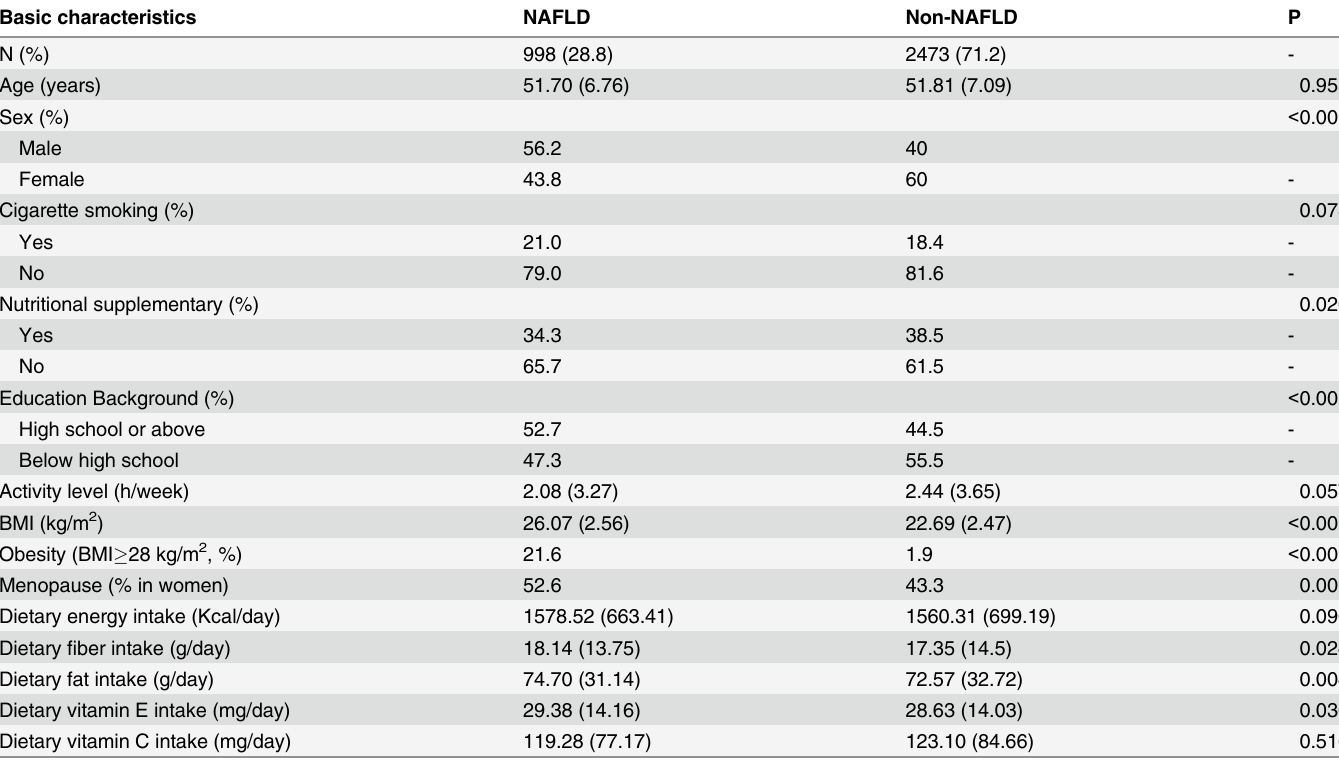
Table 1. Basic characteristics of the study population (n = 3471).